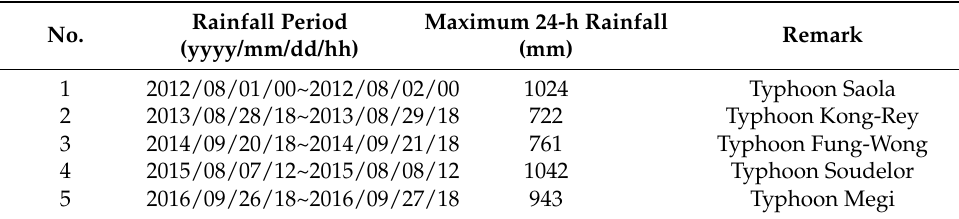
Table 2. List of typhoons used in this study.